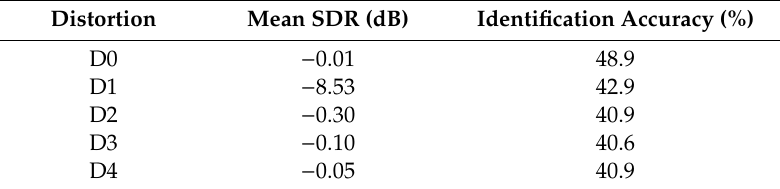
Table 5. SDR and identification result according to frequency band